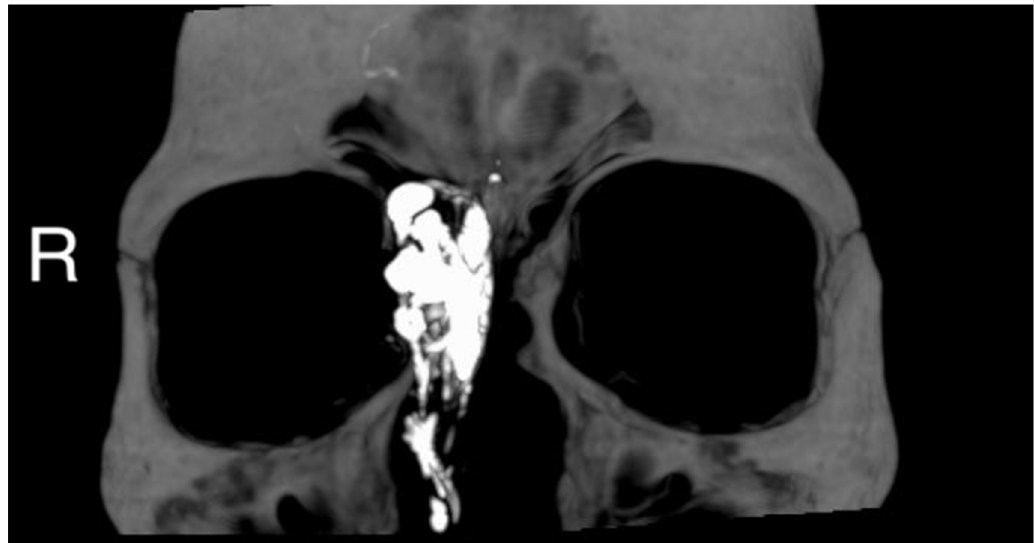
Figure 2. Visualization of the embolized mass in white (3D view). R = right